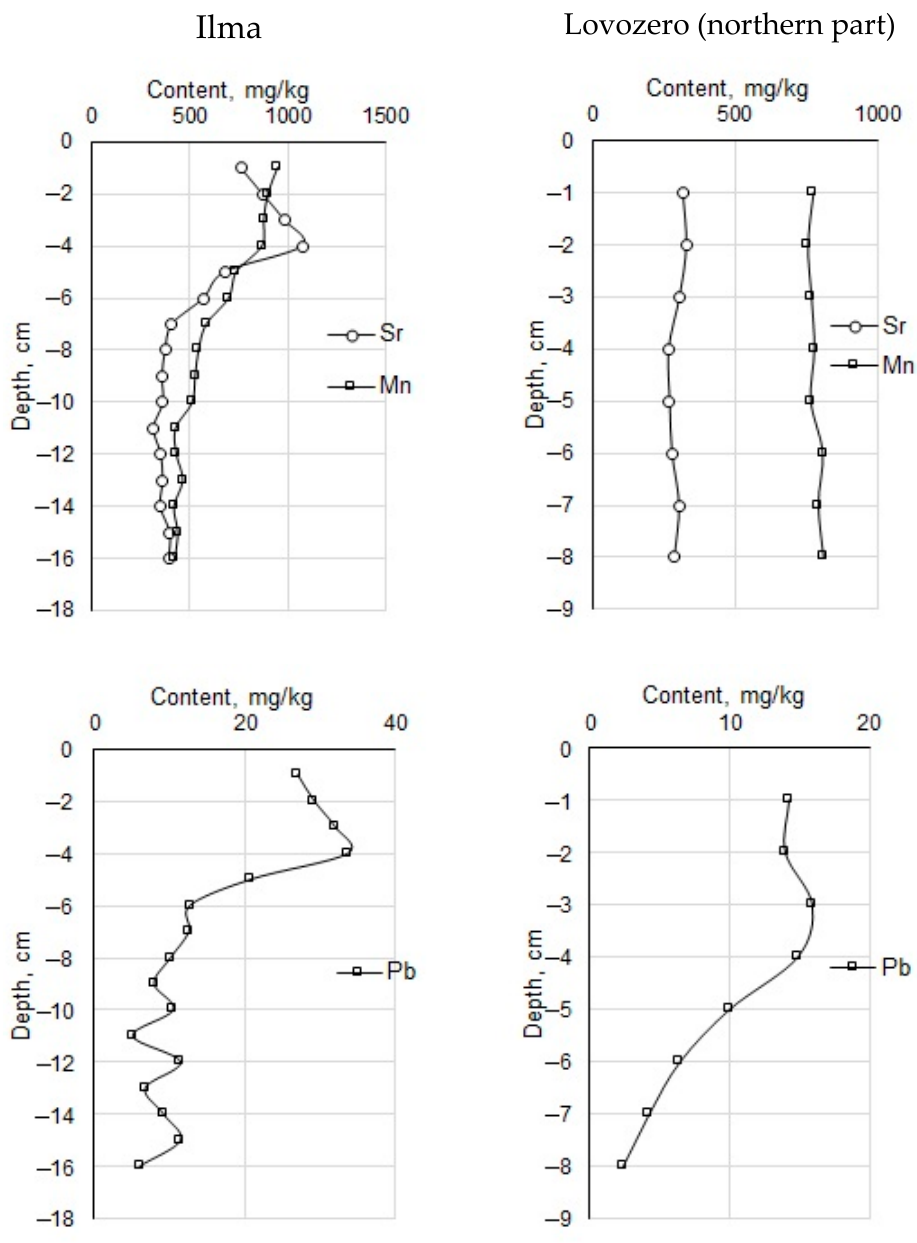
Figure 2. The vertical distribution of the content of some elements in the selected samples of BS of lakes Ilma and Lovozero (northern part).